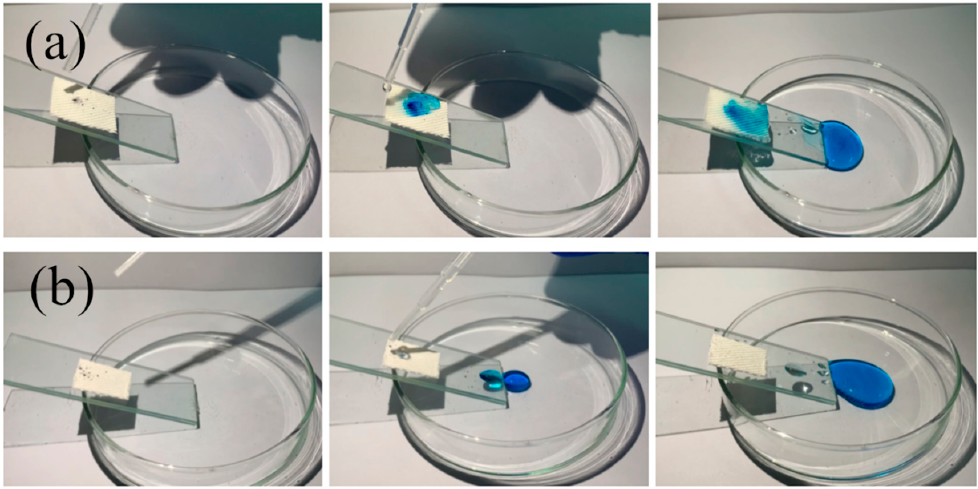
Figure 9. Cotton fabric self-cleaning test of ( a ) pristine fabric and ( b ) superhydrophobic fabric.